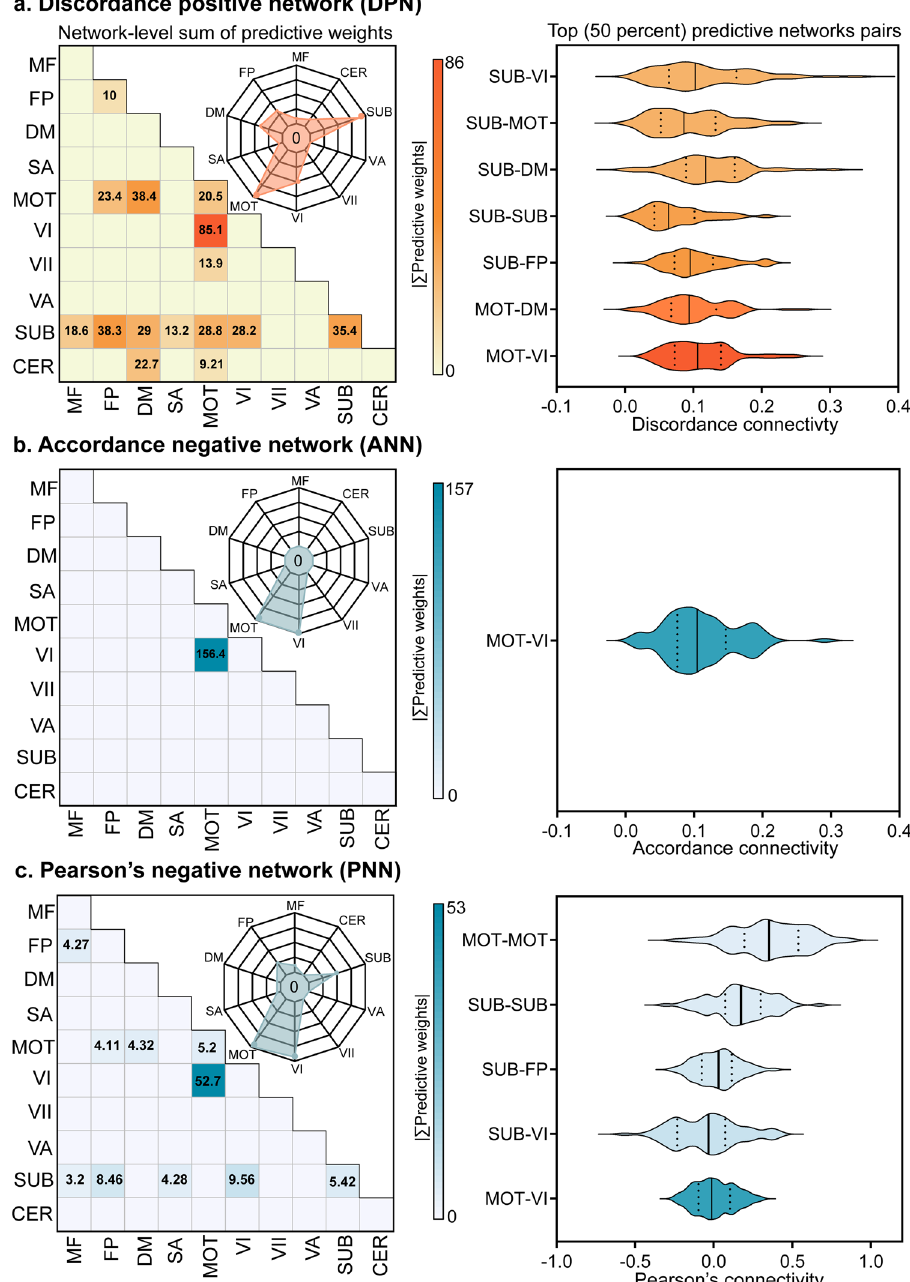
Fig. 3 Network level representation of predictive weights and the distribution of top 50% network pairs on the discovery cohort ( n = 71). 268 ROIs were divided into 10 canonical functional networks, and we characterized the whole predictive networks ( a – c ) from the edge-level (within- and between- networks, shown as heatmaps) and node-level (shown as radar charts) by aggregating all related weights. The fi rst half of the predictive network pairs were selected according to the sorted weights, and the mean strength of network interactions were shown in the second column. The black solid lines in the violin plots represents for the median value, and the dash lines represents for the upper and lower quartiles in each network pair. Networks acronyms: MF Medial Frontal, FP Frontal Parietal, DM Default Mode, MOT Motor, VI Visual I, VII Visual II, VA Visual Association, SUB Subcortical, CER